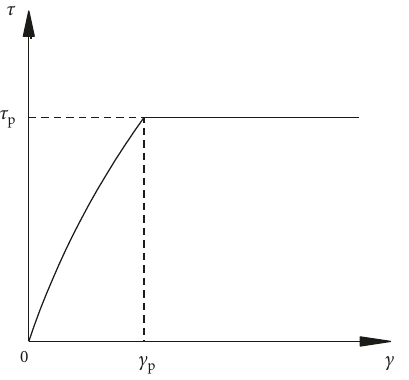
Figure 5: Shear stress-strain curve of the core